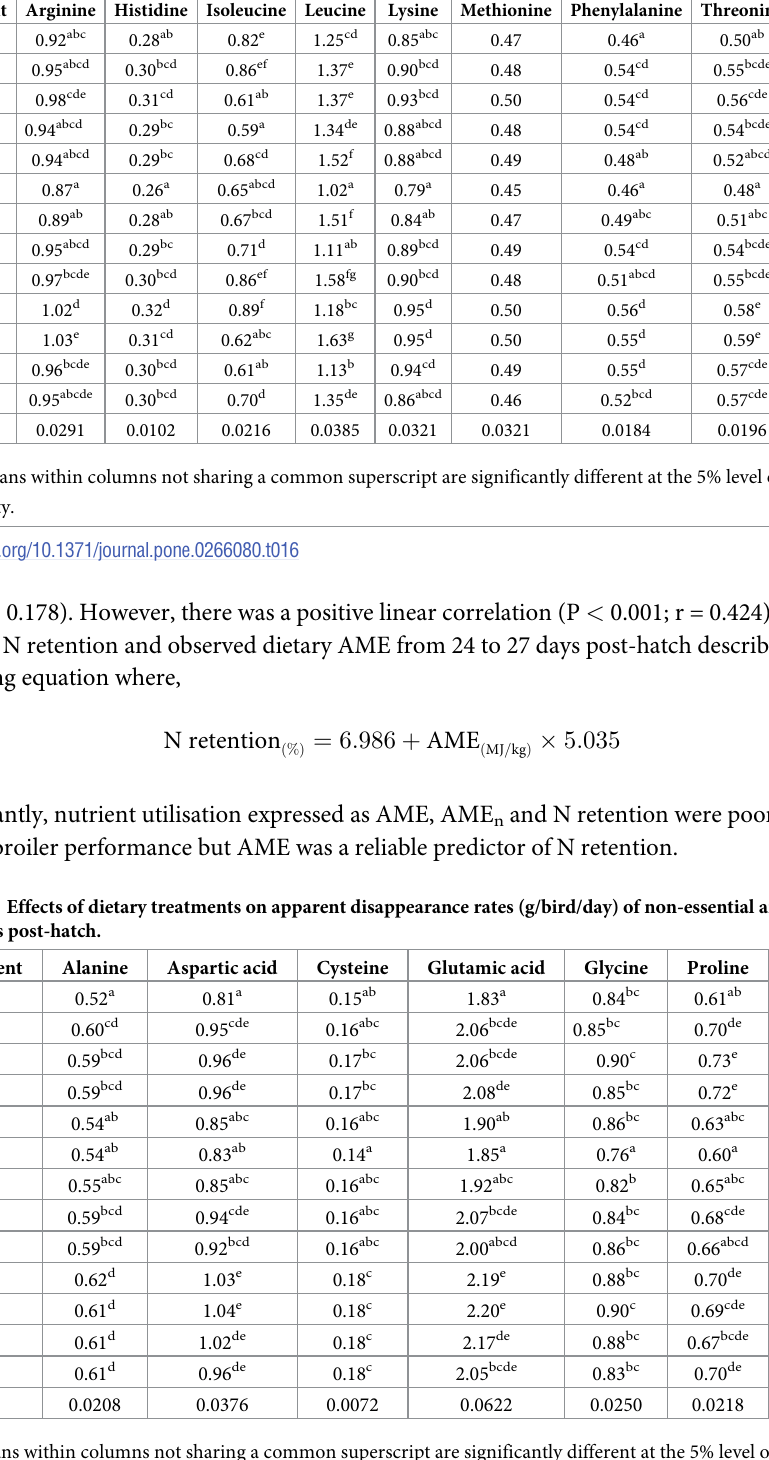
Table 16. Effects of dietary treatments on apparent disappearance rates (g/bird/day) of essential amino acids at 28 days post-hatch. Treatment Arginine Histidine Isoleucine Leucine Lysine Methionine Phenylalanine Threonine Valine